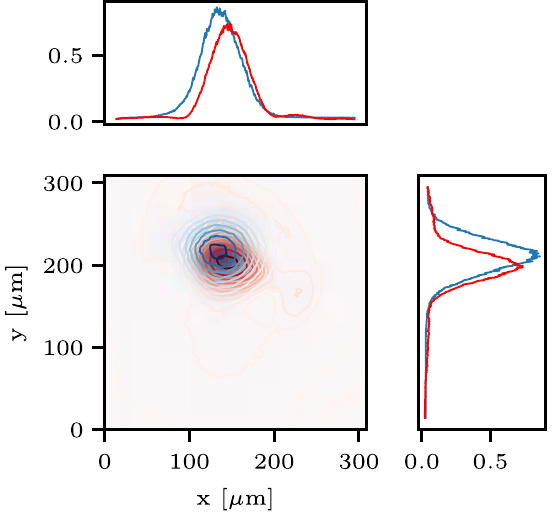
FIG. 32. Experimental measurement, the first laser pass (blue) and last pass (red) measured at the IP by the